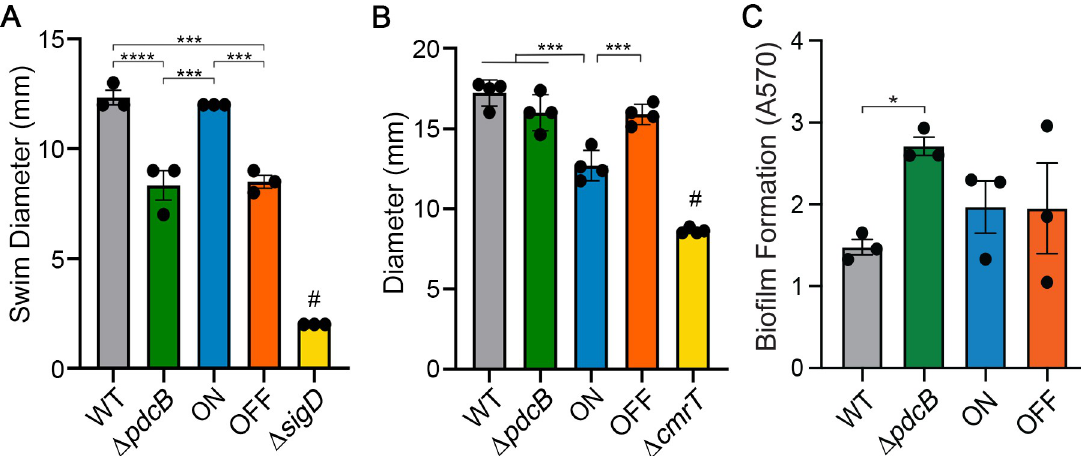
Fig 5. Expression of pdcB affects known c-di-GMP regulated processes. Phenotypic analysis of C . difficile R20291 (WT), Δ pdcB , pdcB Δ 3-ON (ON), and pdcB Δ 3-OFF (OFF). (A) Swimming motility in 0.5x BHIS-0.3% agar after 48 hours. A non-motile mutant ( Δ sigD ) served as a negative control. (B) Surface motility on BHIS-1.8% agar-1% glucose after 6 days. A Δ cmrT mutant served as a negative control. (C) Biofilm formation measured by crystal violet staining after 24 hours of growth in BHIS broth. (A-C) Means and error are shown. Symbols indicate values from independent biological samples. � p < 0.05, ��� p < 0.001, ���� p < 0.0001 by one-way ANOVA and Tukey’s post-test; # p < 0.05 compared to all other